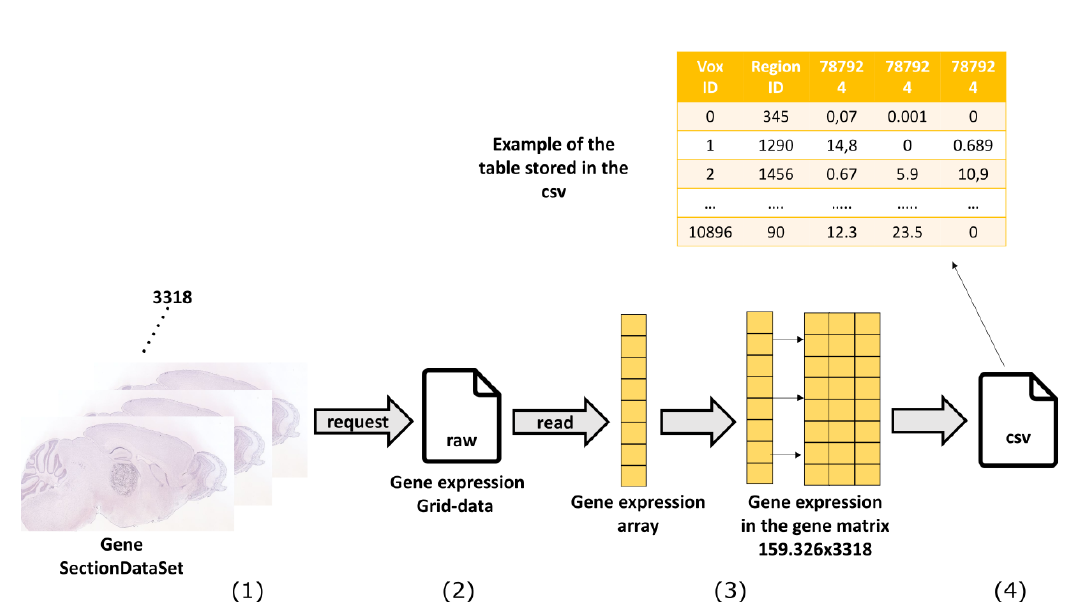
Figure 5. Elaboration of gene expression data: main phases. ( 1 ) Retrieve a SectionDataset for each of the 3318 genes; ( 2 ) download grid expression data in the form of an energy.raw file; ( 3 ) reconstruct a 3318 × 159,326 matrix of gene expression levels, with rows corresponding to genes and columns to 3D voxels; ( 4 ) store data into a .csv